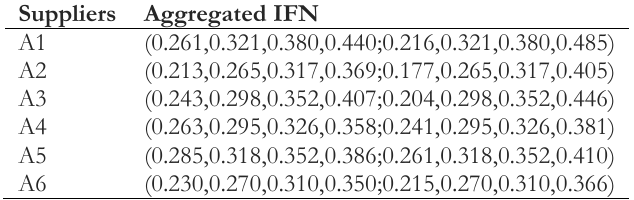
Table 8. Final aggregation of experts' preferences for each alternative.